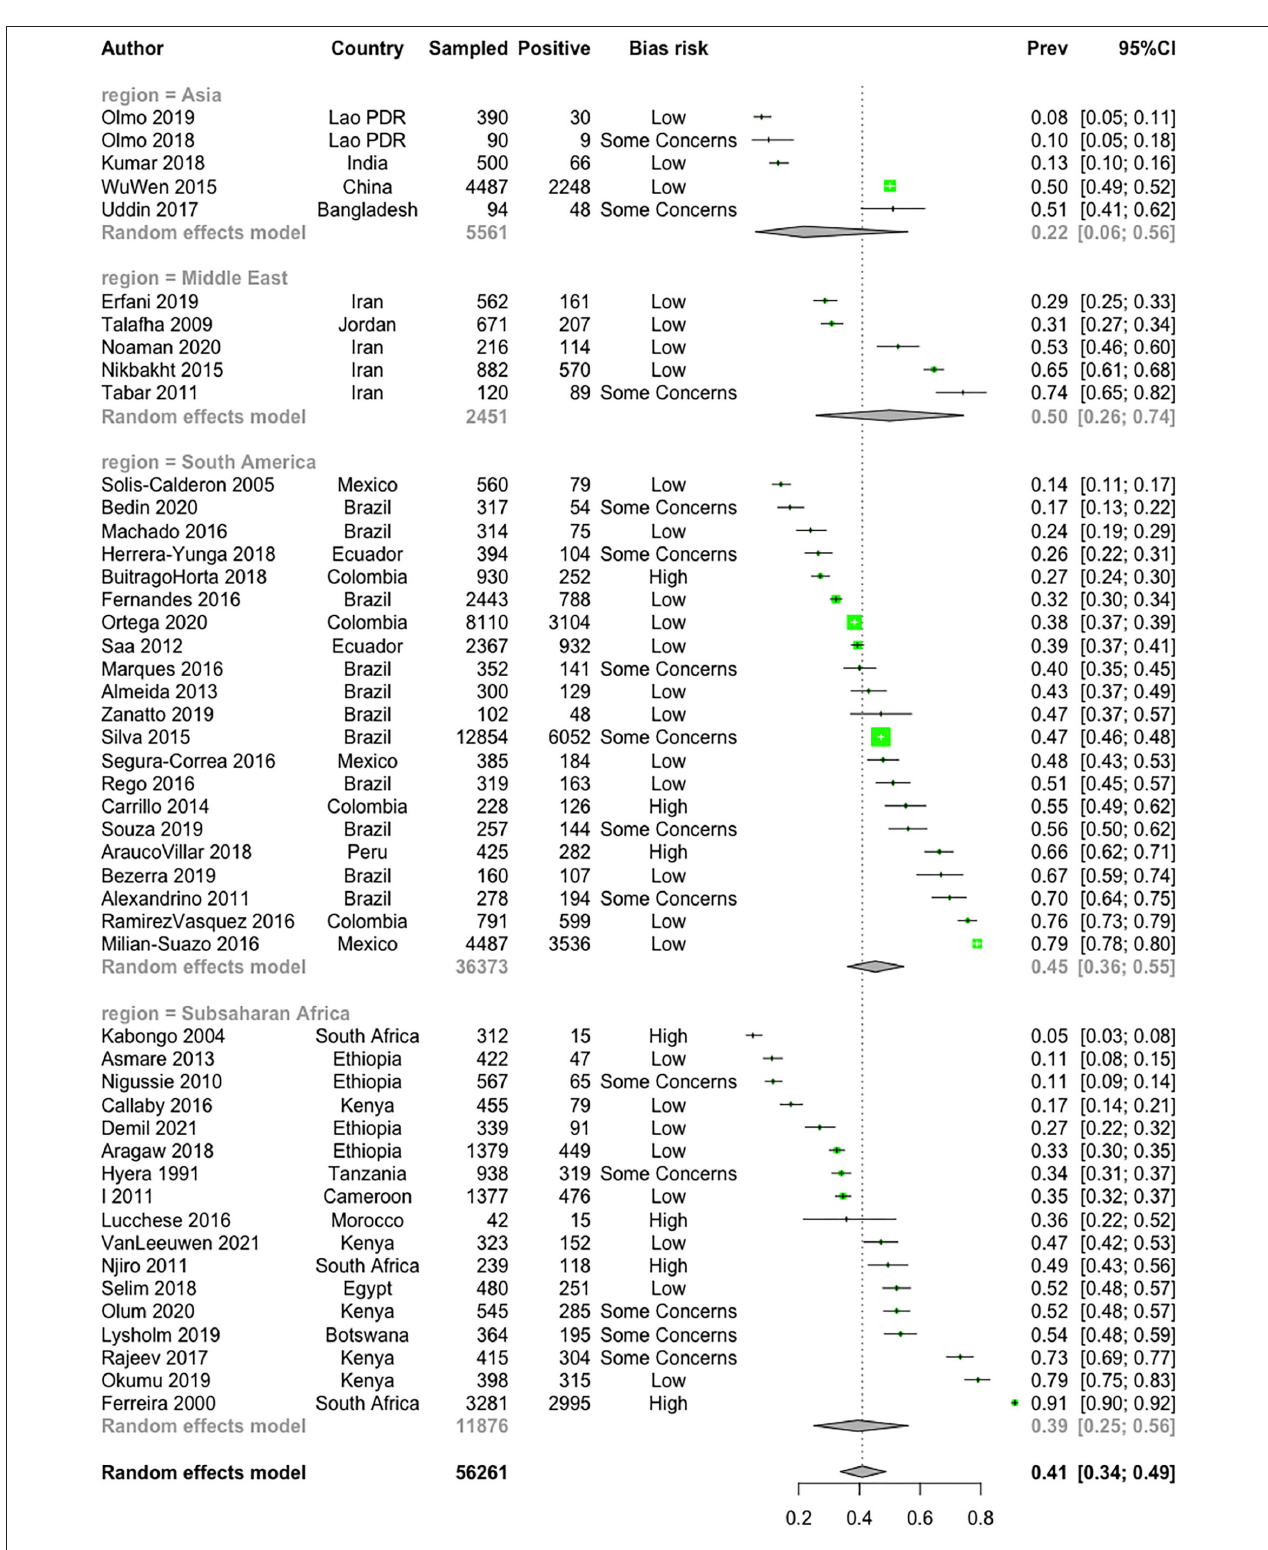
FIGURE 5 | A forest plot of the weighted meta-analysis of reported BVD antibody seroprevalence by country. The plot shows the study ID, the country where the study was conducted, the sample size, the number of positive test results for antibodies to BVDV, the risk of bias rank overall, the point estimate with 95% confidence interval with the box proportional to the weighting of the fixed effect, the numerical value of the point estimate of BVD prevalence (the effect size) and the estimated 95% confidence interval (unadjusted in black, weighted adjusted in green).